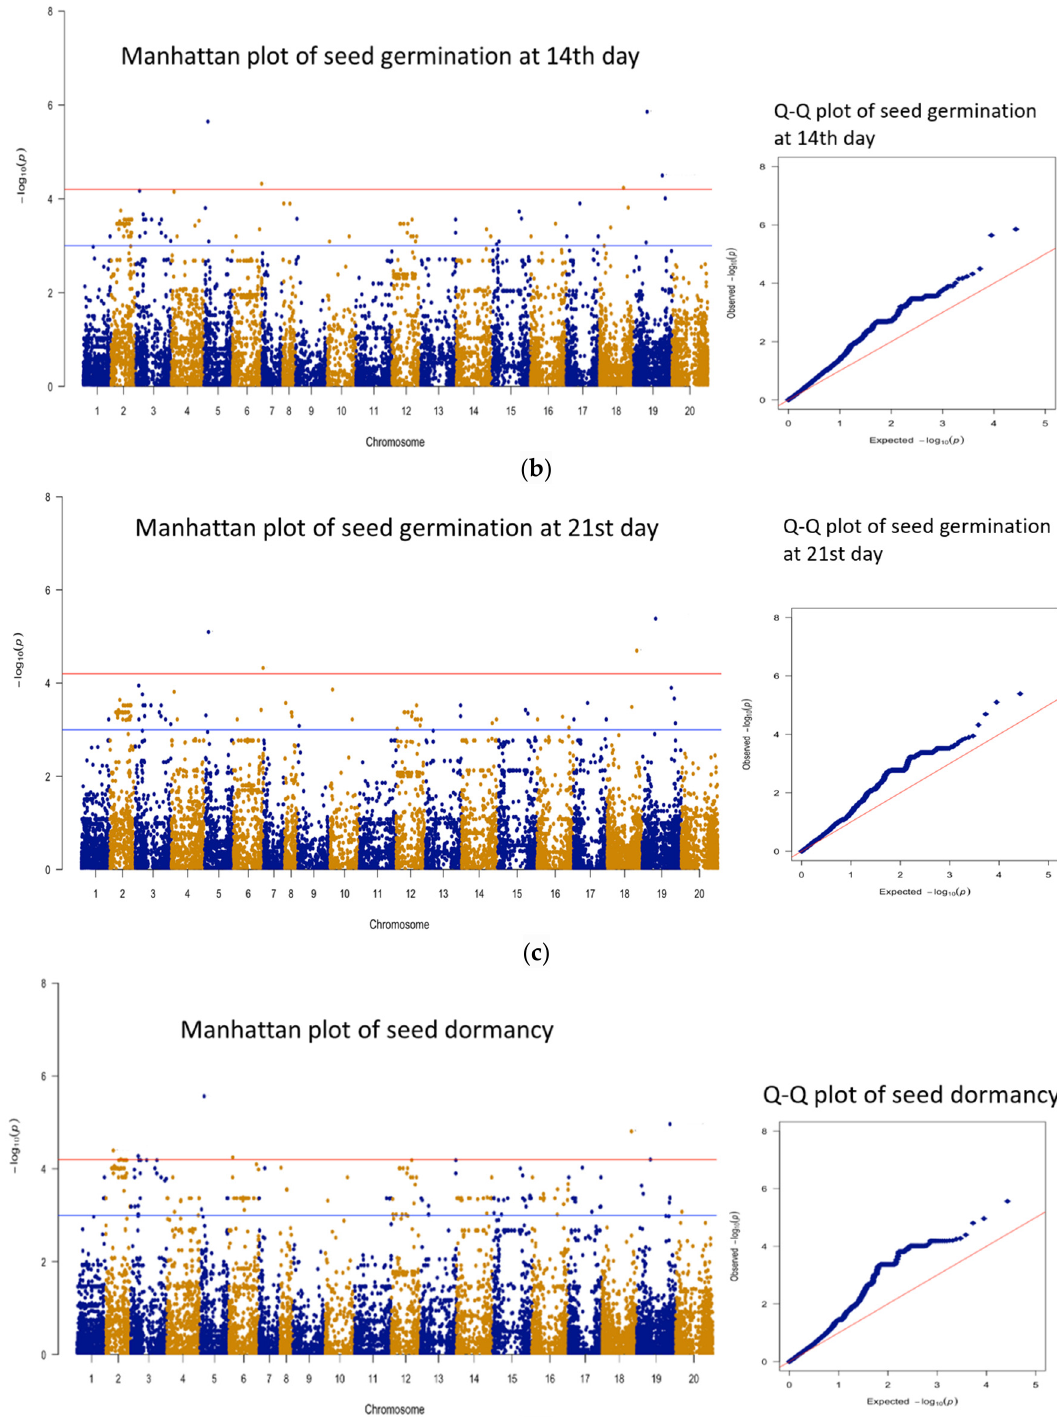
Figure 3. Manhattan and Q − Q plots for seed germination rate at the 7th ( a ), 14th ( b ), and 21 days ( c ), and seed dormancy ( d ). Significant threshold is marked by a red line, and suggestive threshold is marked by a blue line in the Manhattan plot.